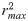
Controls and extensions of the main analysis.(a) Comparison of the best goodness-of-fit scores achieved for each combination of neuron and test frequency that had significant response in the ‘equiprobable’ block (p = 50%) and the goodness-of-fit score of the same neuron and frequency in the main analysis (using all responses with p = 10%, 50% and 90%). Significant scores in the equiprobable block are indicated in red (permutation test, p<0.05). (b) Fraction of cases with significant effects of prediction error on the neuronal responses for all the single-block analyses. (c) Fraction of cases with significant effects of prediction error on the neuronal responses in different time windows (marked below the histogram) and for different selection of blocks. (d) Comparison of the fraction of explained variance (rmax2) and the fraction of explainable variance. The red points corresponds to correction by a noise estimates using unbiased variances, while the green points correspond to the conservative correction by the (smaller) noise estimates using the biased variances. (e) Comparison of SSA indices (SI) and explained variance (rmax2). Cases with significant correlation (permutation test, p<0.05) are indicated by blue (low tones) or red (high tones).